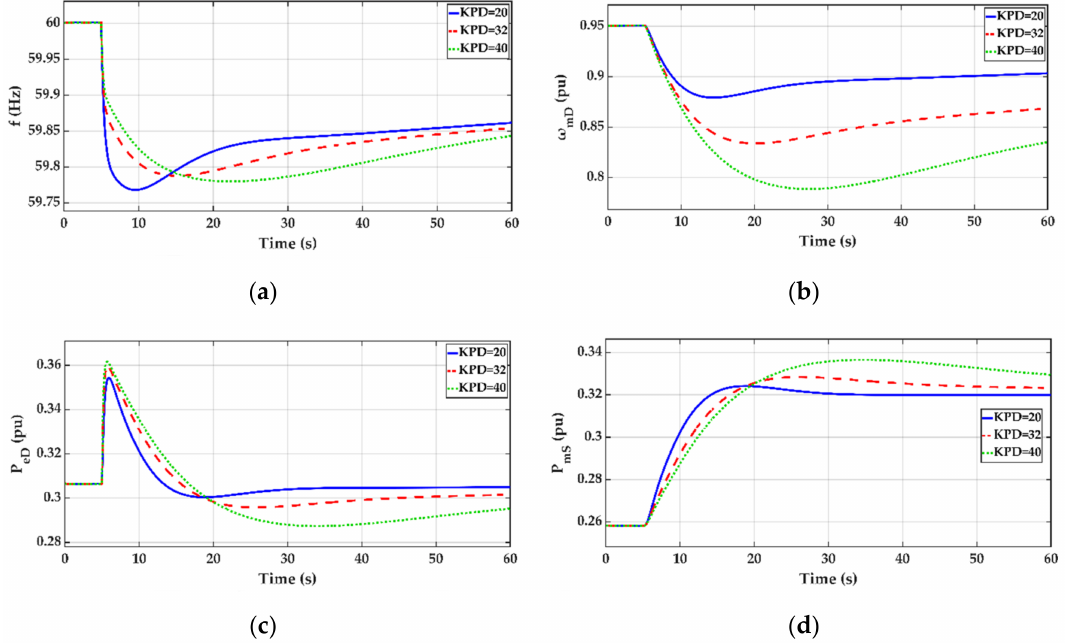
Figure 2. Dynamic response curves for a load disturbance of ∆ P Load = 30 MW (wind penetration = 29.4% and V = 11 m / s). ( a ) Frequency, ( b ) DFIG speed, ( c ) DFIG electrical power, and ( d ) SG W mechanical power. K PD : the optimal